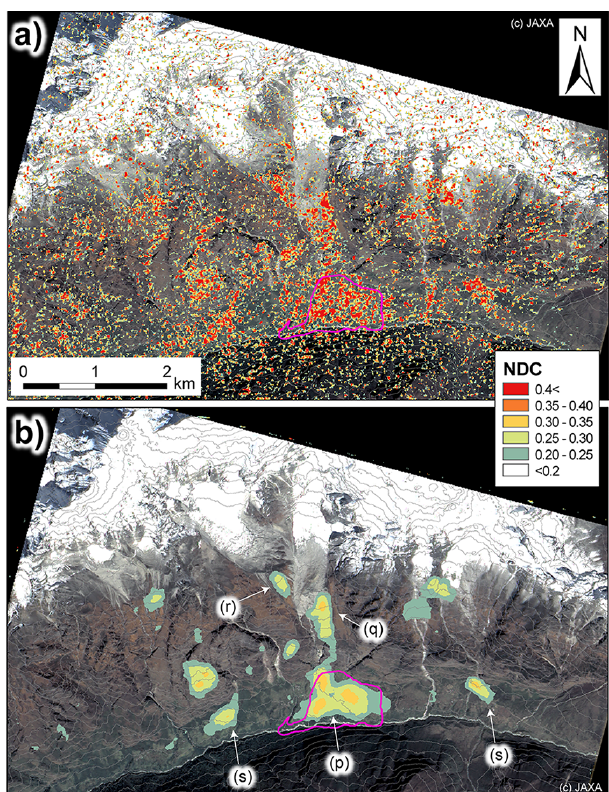
Figure 6. Normalized coherence decrease around the collapsed area in Langtang Valley. (a) Original output image is processed into an image of focal statistics with (b) 15m circles for calculating the mean values. High-value parts are denoted on (p) the collapse area, (q) a glacier moraine, and (r) a tributary glacier, as well as (s) two places on the valley bottom. The background is an ALOS pan- sharpened image observed on 12 October